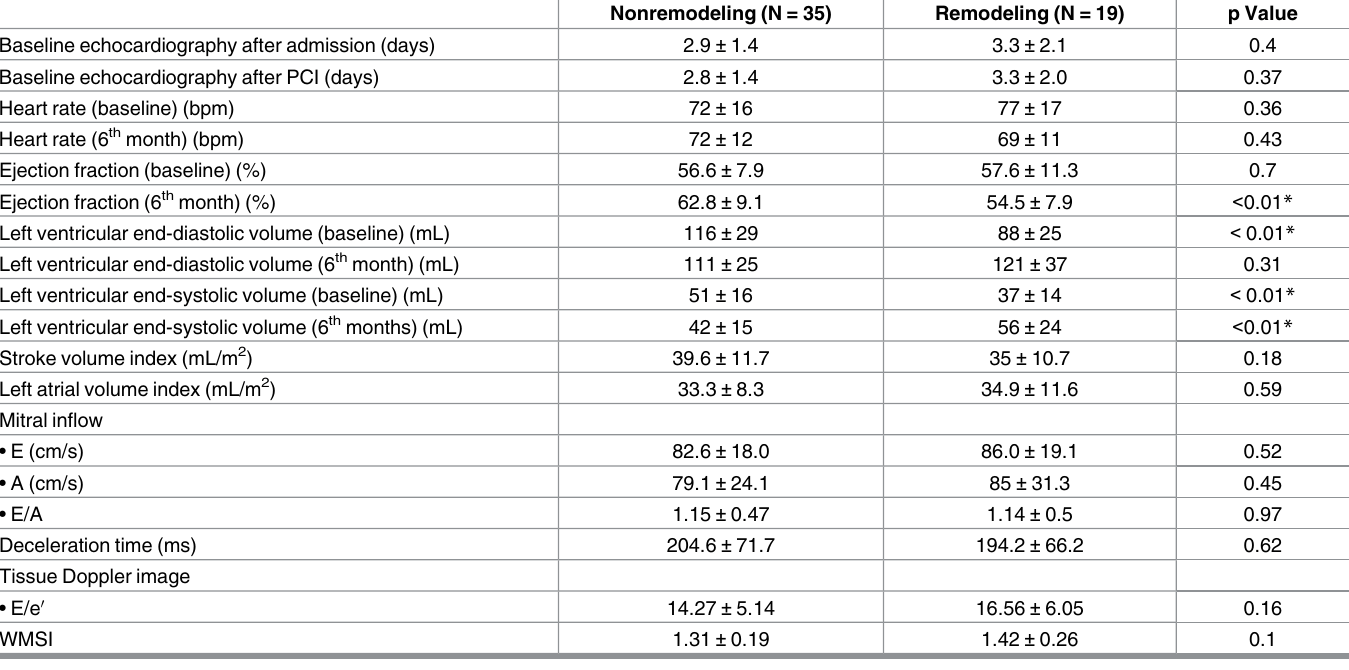
Table 6. Echocardiographic findings in STEMI